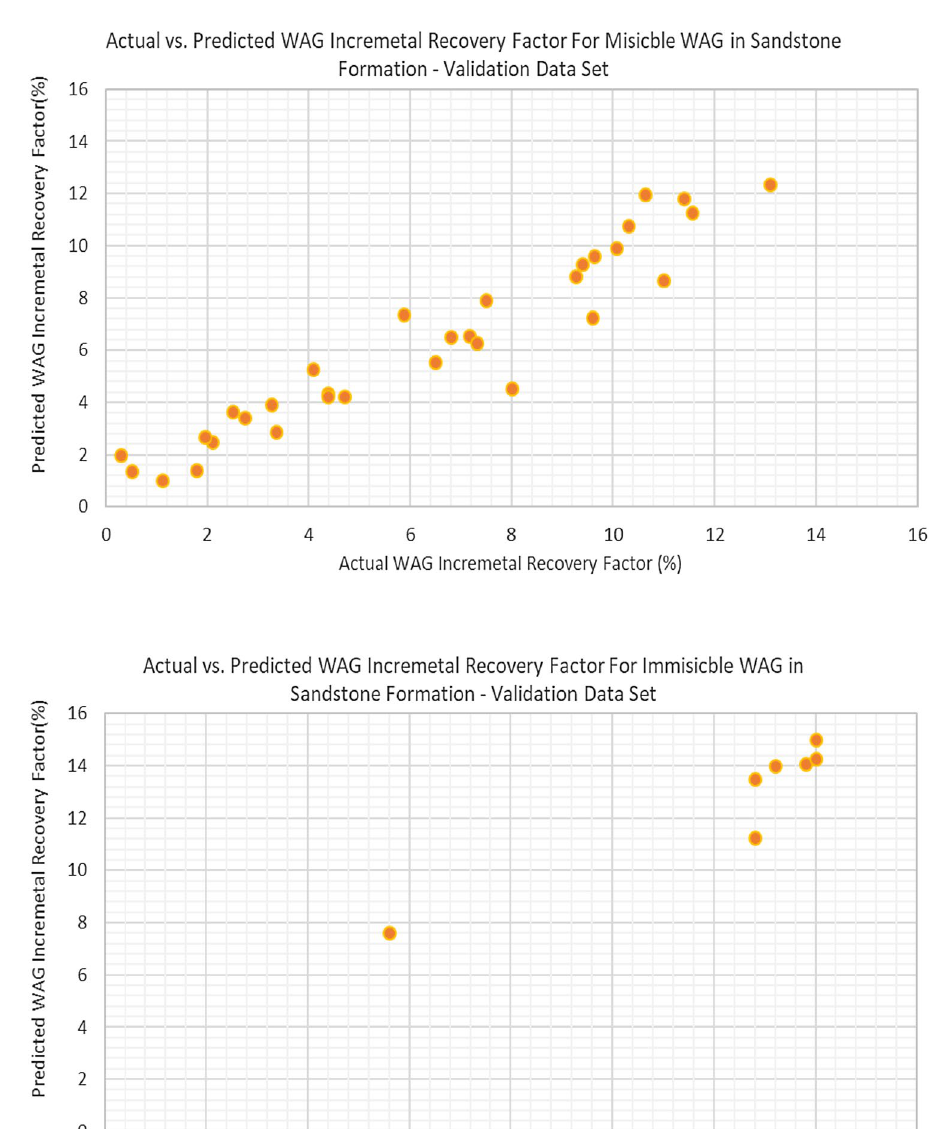
Fig. 9 Regression WAG incre-